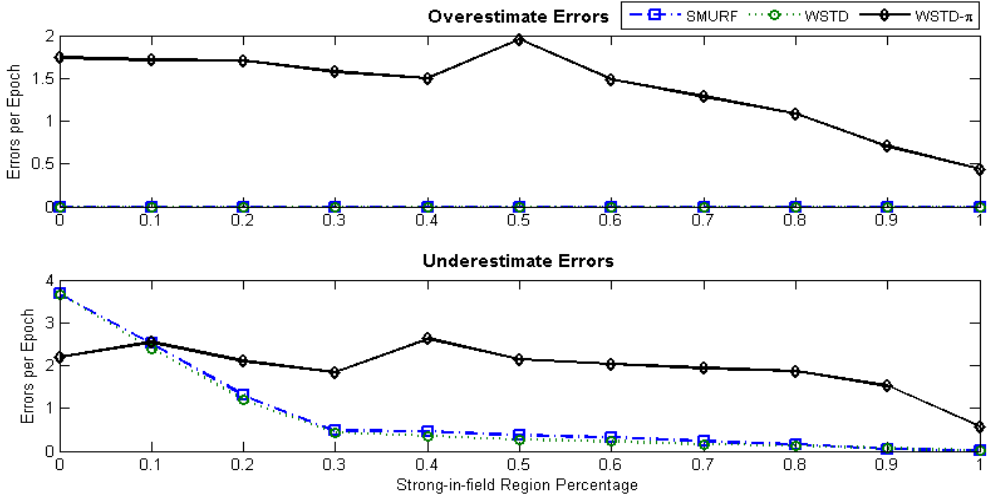
Figure 25. Variable window schemes’ average overestimates and underestimates error contributions as the StrongPercentage parameter is varied in the static tag environment.